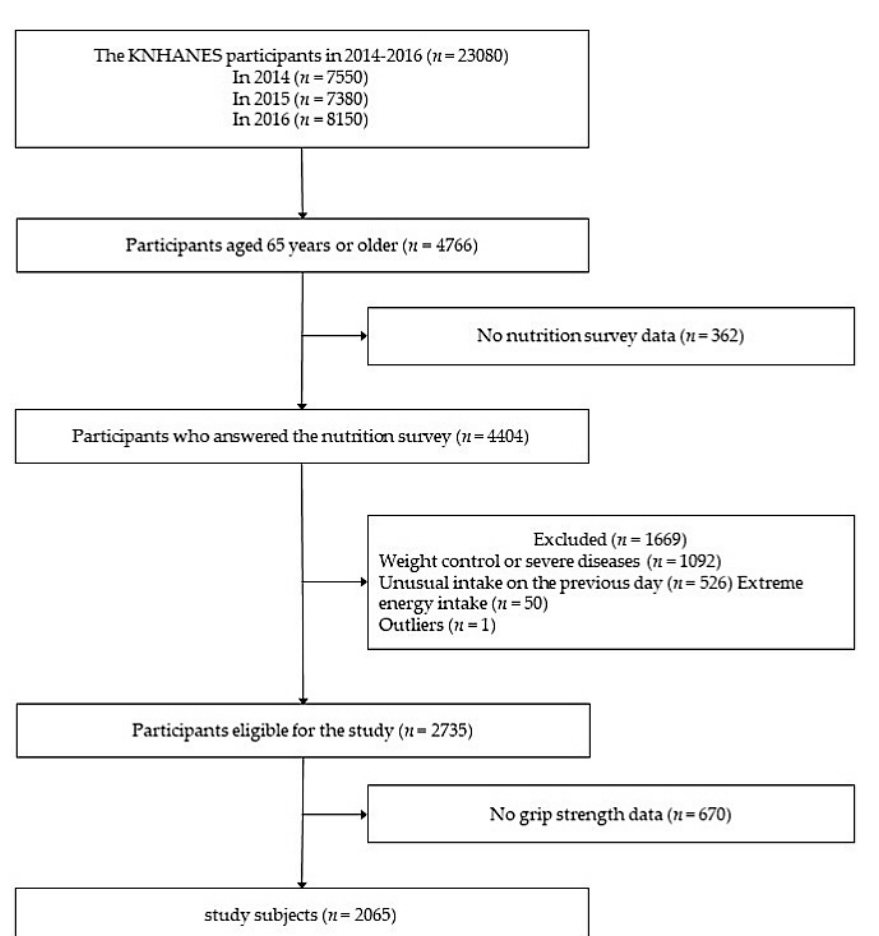
Figure 1. Flowchart of the study subjects.